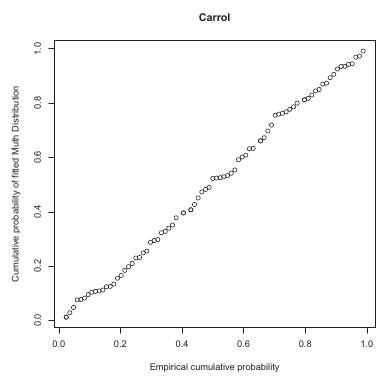
Figure 2. Fitted scaled Muth distribution to Carrol data set.